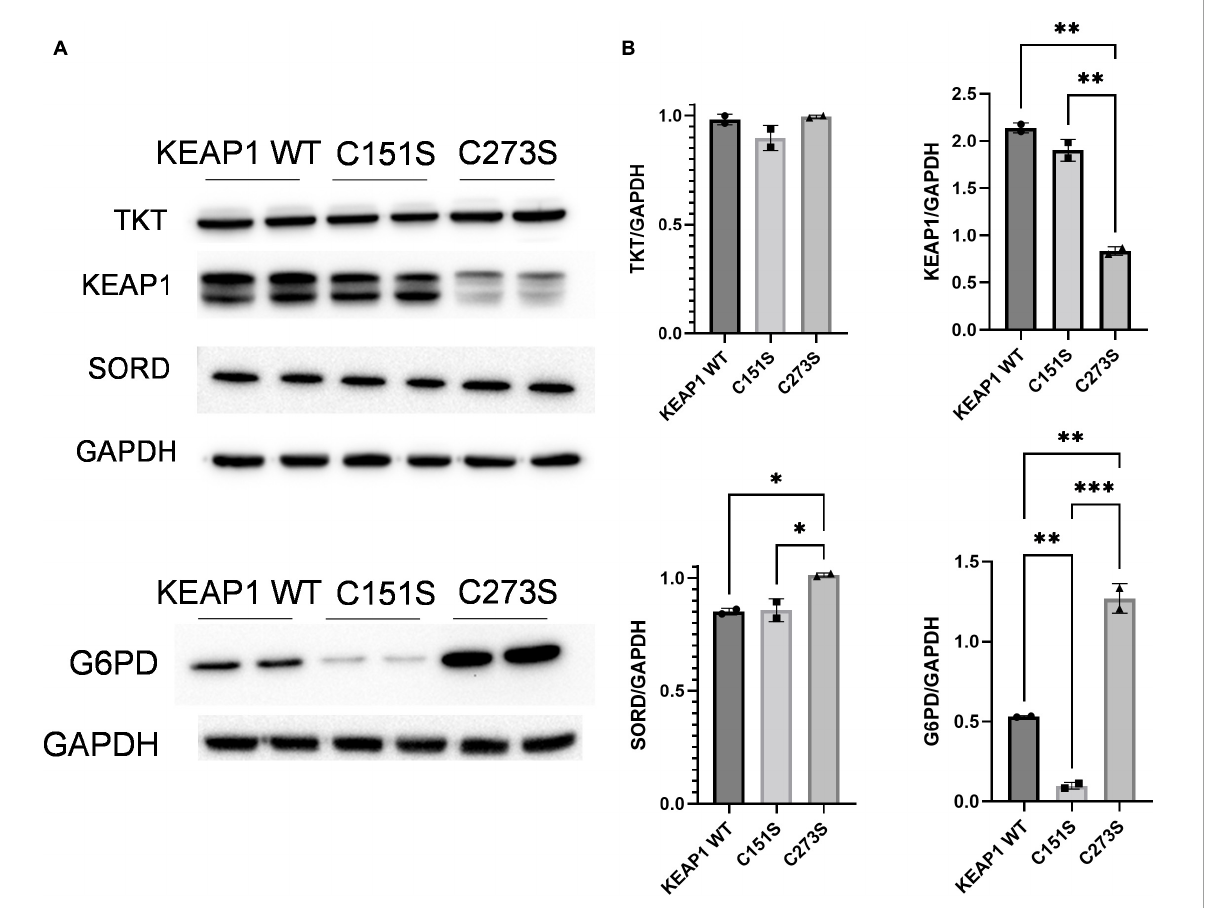
FIGURE8 KEAP1 variants have modified expression of proteins regulated by NRF2. (A) Western blots of TKT, KEAP1, SORD, and G6PD expression in KEAP1 mutant cells and (B) quantification of protein expression. Expression was quantified with ImageJ ( n = 3). G6PD, glucose-6-phosphate dehydrogenase; GAPDH, glyceraldehyde-3-phosphate dehydrogenase; KEAP1, Kelch Like ECH Associated Protein 1; SORD, sorbitol dehydrogenase; TKT, transketolase. ∗ p < 0.05, ∗∗ p < 0.01, ∗∗∗ p < 0.001.